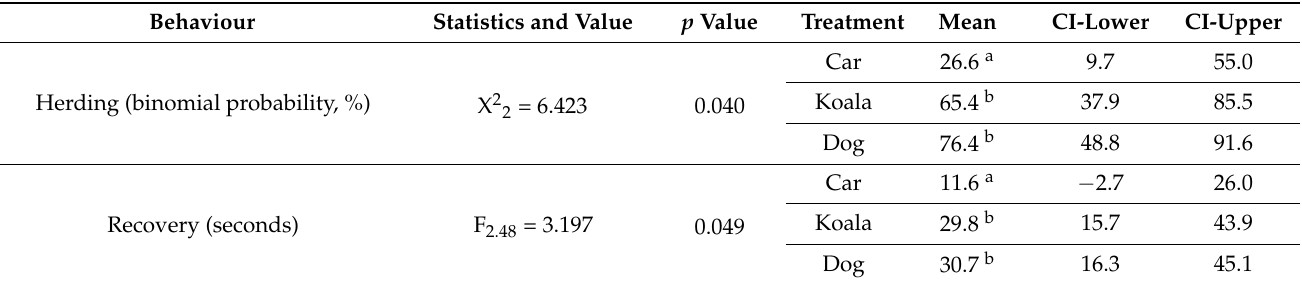
Table 6. Effects of treatments (Koala = koala model, Dog = dog model, Car = car without models) on cattle behavioural reactions in Experiment 2. Within each behaviour, treatments followed by the same superscript are not significantly different, using Tukey’s test. Adjusted proportion = aggregated behaviour duration/(test duration × total number of animals in the test). All percentage (%) means are within a test